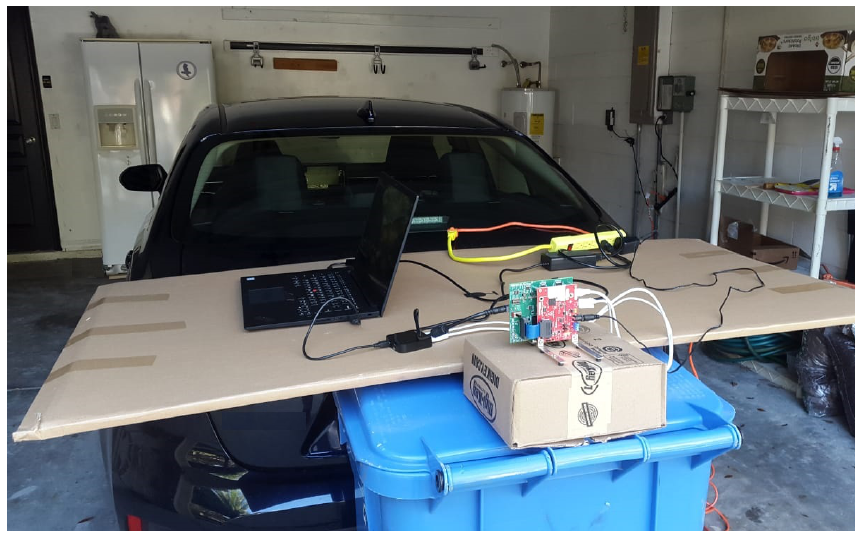
Figure 6. A field experiment using the AV radar sensor.